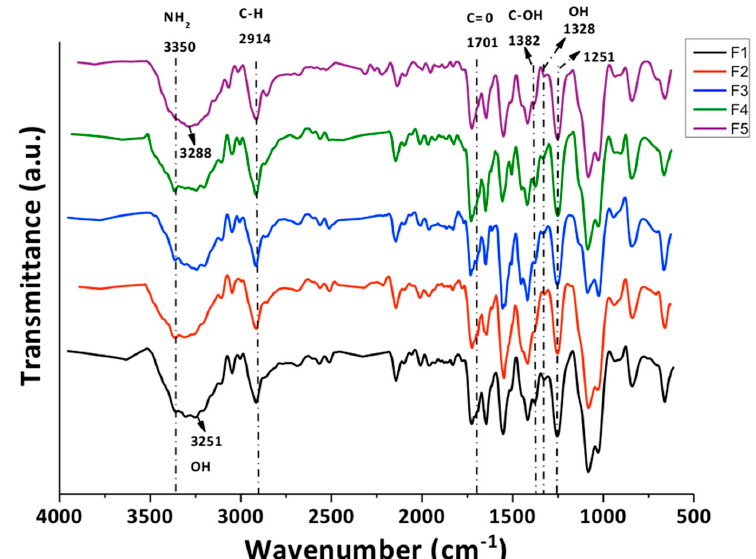
Figure 4. Attenuated total reflectance Fourier-transform infrared (ATR-FTIR) spectroscopy of chitosan/poly(vinyl alcohol)/graphene oxide (CS/PVA/GO) films for the five formulations. F1: CS/PVA/GO 20:80:0; F2: CS/PVA/GO 14.75:85:0.25; F3: CS/PVA/GO 19.5:80:0.5; F4: CS/PVA/GO 14.25:85:0.75 and F5: CS/PVA/GO 29:70:1. All the ratios are wt